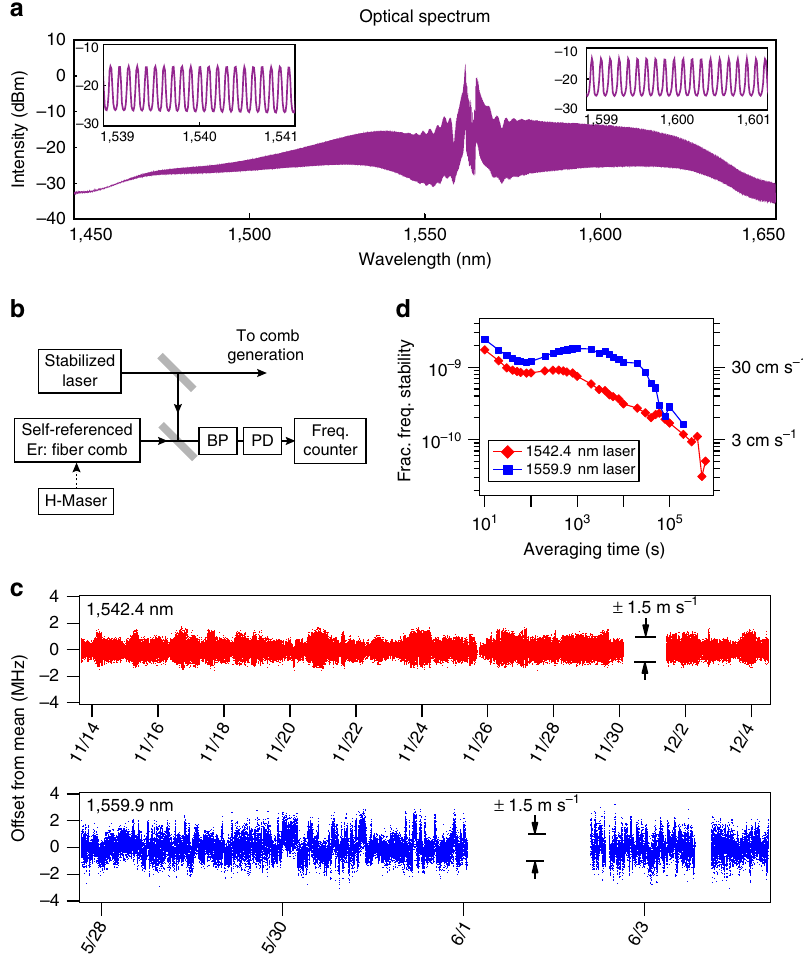
Figure 3 | Comb spectra and stability of the C 2 H 2 and HCN reference lasers. ( a ) A typical comb spectrum from the 1,559.9nm laser with 4 100nm span generated with 600mW pump power. The insets show the resolved line spacing of 12GHz or B 0.1nm. ( b ) Experimental set-up: BP, optical band-pass filter; PD, photodiode. All beam paths and beam combiners are in single mode fibre. ( c ) Time series of measured beat frequencies for the two frequency- stabilized lasers with 10s averaging per measurement. The x axes are the dates in November of 2013 and May/June of 2014, respectively. ( d ) Allan deviation, which is a measure of the fractional frequency stability, computed from the time series data of c . Right-side scale gives the radial velocity